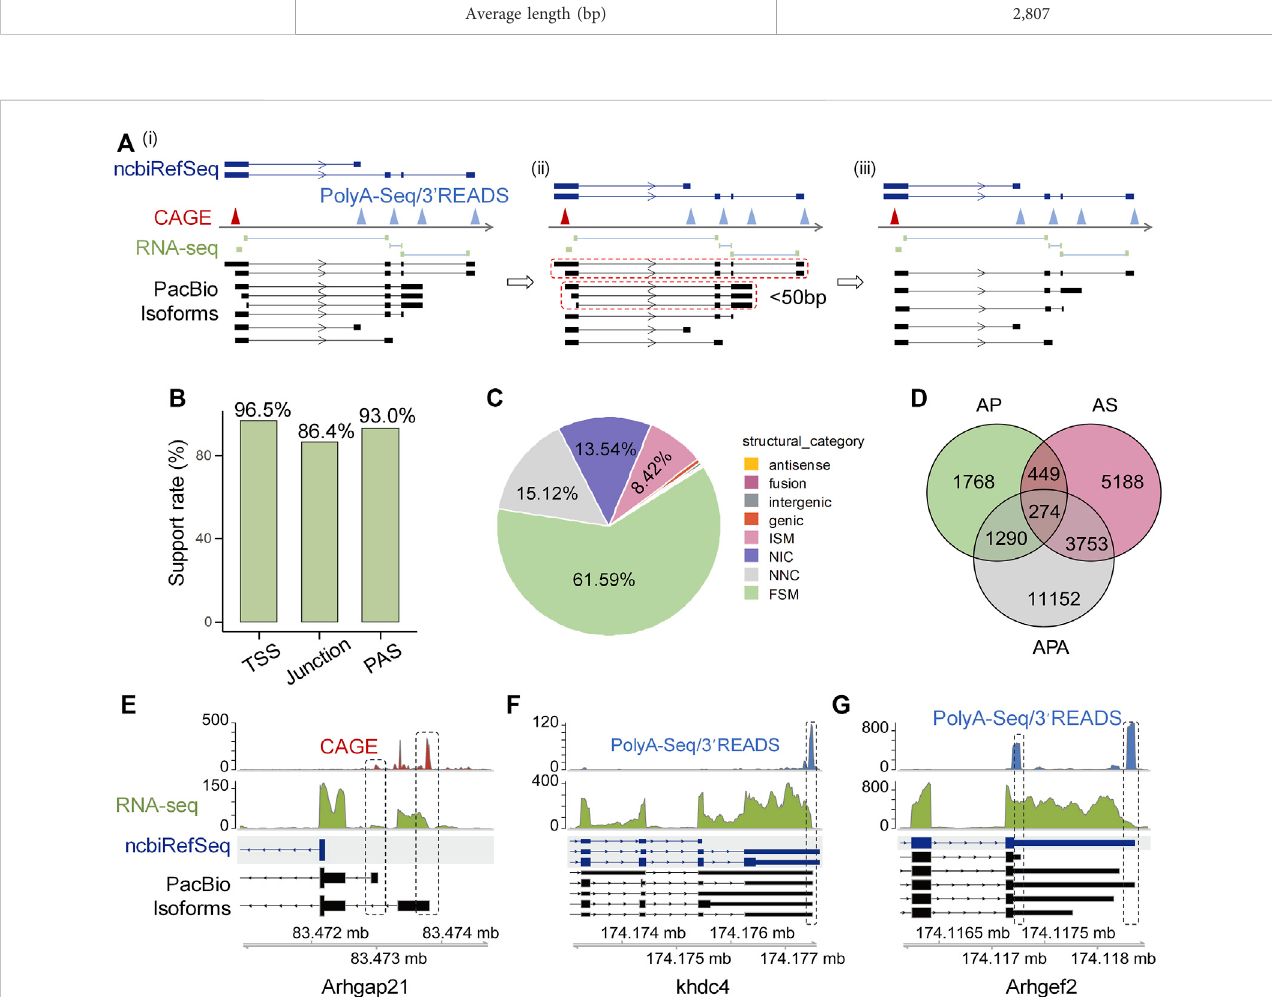
FIGURE 1 High con fi dent full-length isoforms improve rat genome annotation. (A) The schematic diagram illustrating the cross-validation of full-length transcript end based on CAGE, PolyA-Seq and 3 ′ READ. The transcriptome construction involves three steps. Step i: We generated validated pools of 5 ′ -ends, splicing junction and 3 ′ -ends from CAGE, short junction reads, PolyA-Seq and 3 ′ READS, respectively, followed by comparing the aligned Iso-Seq isoforms with the validated 5 ′ -end, junction, and 3 ′ -end pool. Step ii: Mark those isoforms with the same splicing structure and PAS within 50 nt and only display 5 ′ UTR difference (dotted closed circle). Step iii: We keep the one whose TSS is closest to the validated 5 ′ -ends pool. (B) The support rate of PacBio isoforms for TSS, junction, and PAS independently. (C) Types and percentages of eight categories of PacBio de fi ned transcripts. (D) Venn diagram shows the number of PacBio isoforms that differ from ncbiRefSeq in transcriptional start sites (TSS), alternative splicing (AS), and alternative polyadenylation (APA). (E) Arhgap21 as an example to show novel isoforms with novel TSSs when compared to ncbiRefSeq and were supported by CAGE. (F) Khdc4 as an example to show novel isoforms with intron retention when compared to ncbiRefSeq annotation and were supported by PacBio and RNA-seq. (G) Arhgef2 as an example to show novel isoforms with proximal PAS when compared to ncbiRefSeq annotation and were supported by PacBio and PolyA-Seq/3 ′